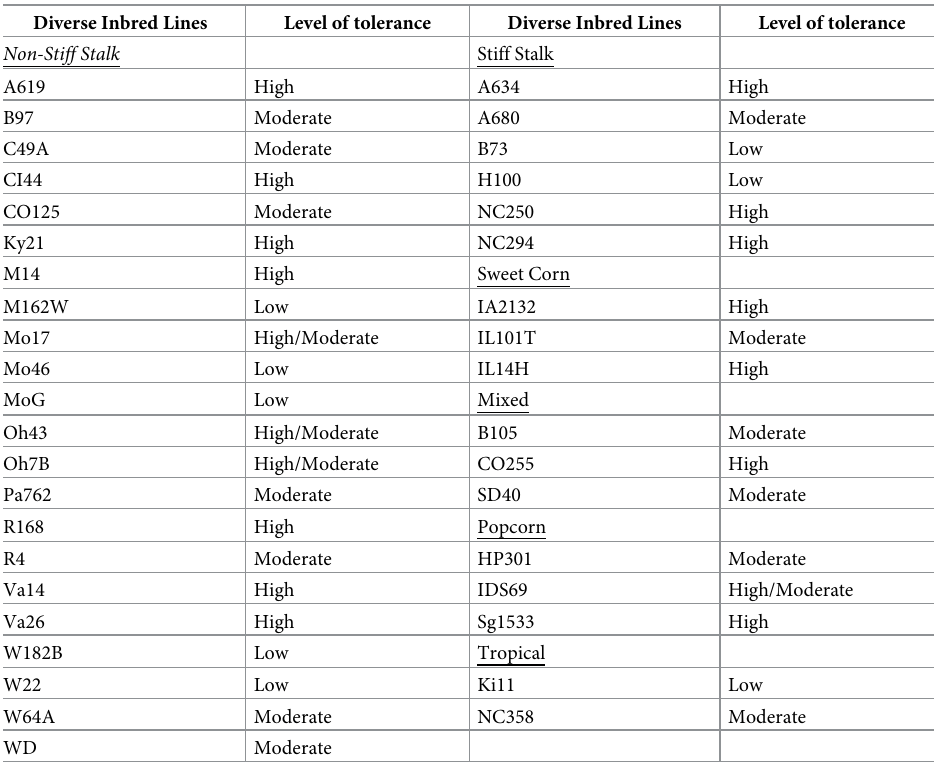
Table 2. Diverse inbred lines show various degrees of seedling tolerance to low temperature exposure. Diverse Inbred